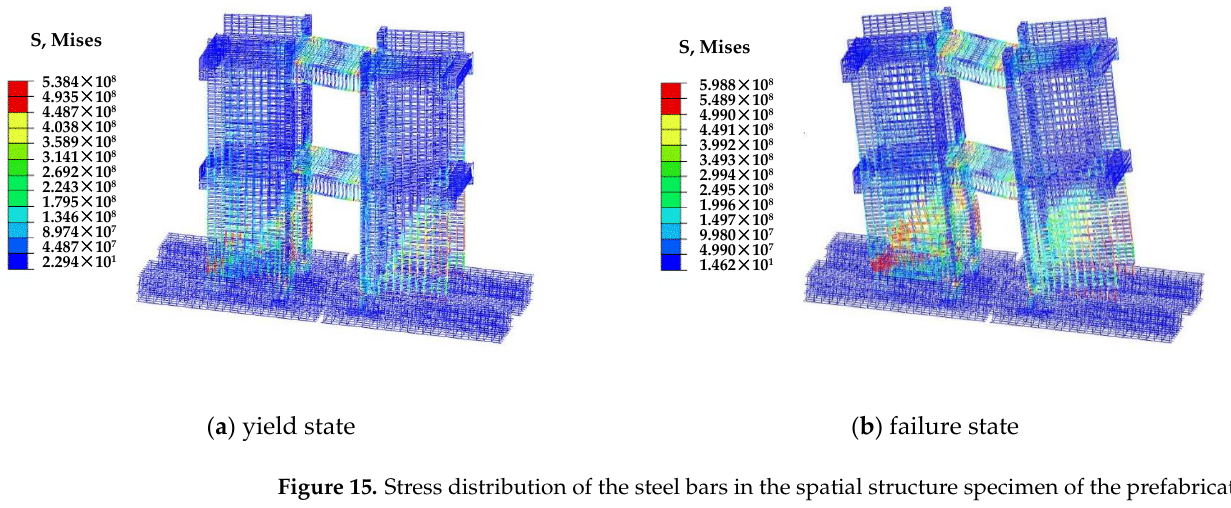
Figure 15. Stress distribution of the steel bars in the spatial structure specimen of the prefabricated ECC/RC combined shear wall.